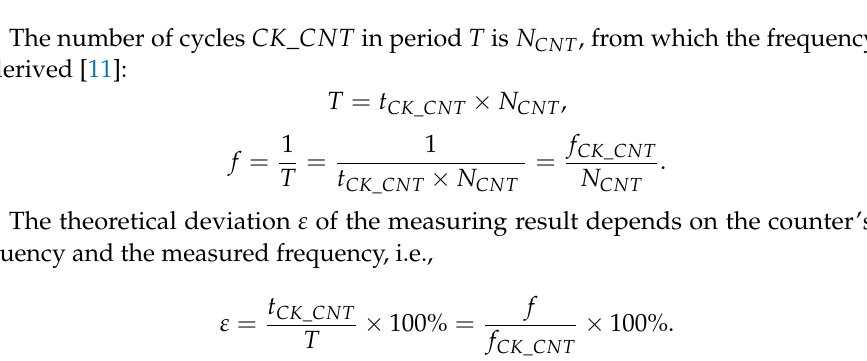
Figure 2. Schematic diagram of square wave period measurement method.